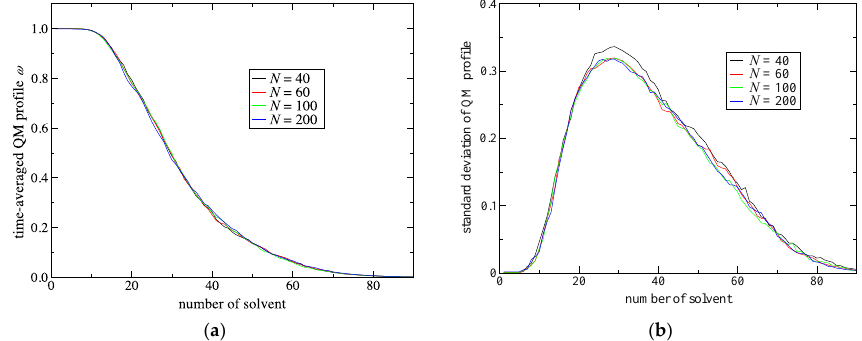
Figure 3. ( a ) Time-averaged QM profiles, ω , and ( b ) their standard deviations obtained from 100 ps SCMP simulations. The horizontal axis represents the solvent number from the QM solute. Black, red, green and blue lines represent the results obtained by the SCMP method with number of partitionings equal to 40, 60, 100 and 200, respectively.